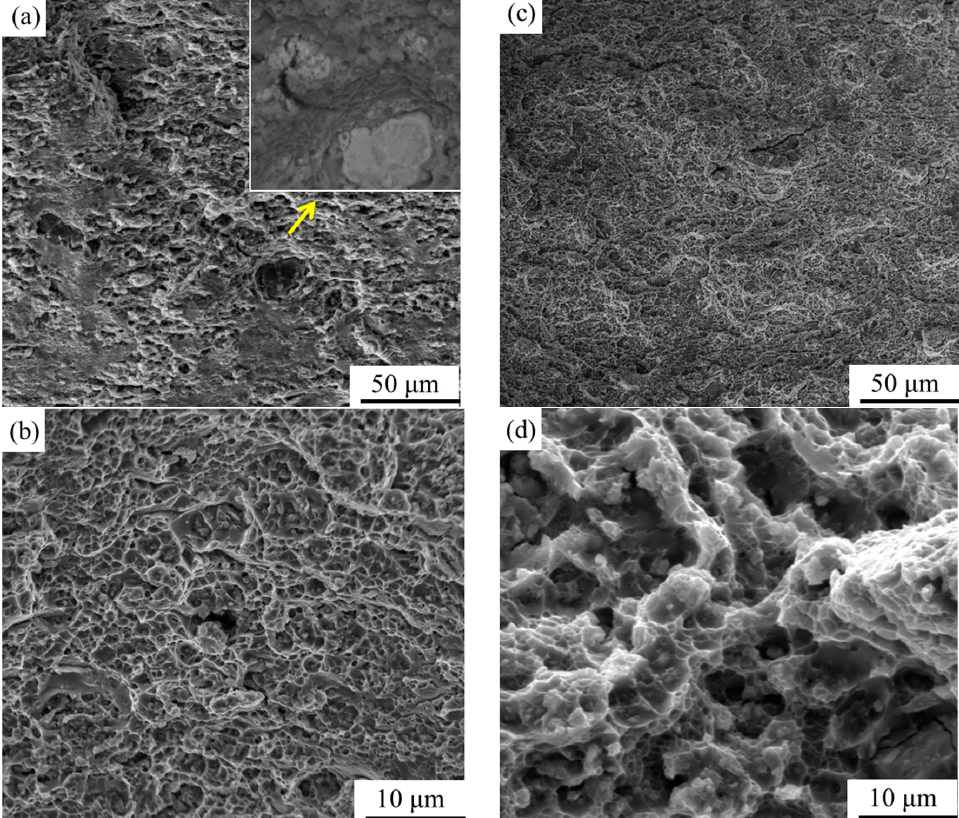
Figure 9. Tensile fracture morphologies of specimens under different post-aging conditions: ( a ) CR, ( c ) CR@100 °C/12 h; ( b ) and ( d ) are high magnification images. The inset in ( a ) is a high-magnification backscattered electron image of zone pointed by arrow.